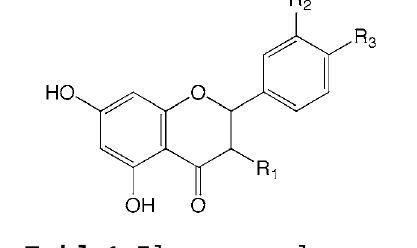
Table 1. Flavanone